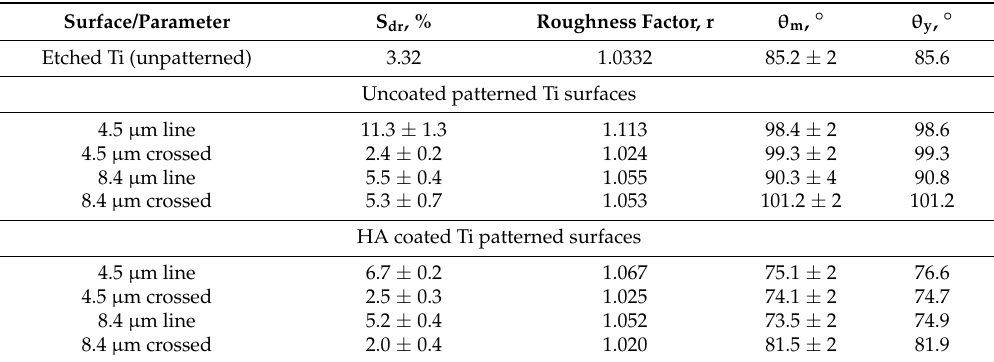
Table 2. Summary of the θ m and θ y calculated for a 35 × 35 µ m 2 scan